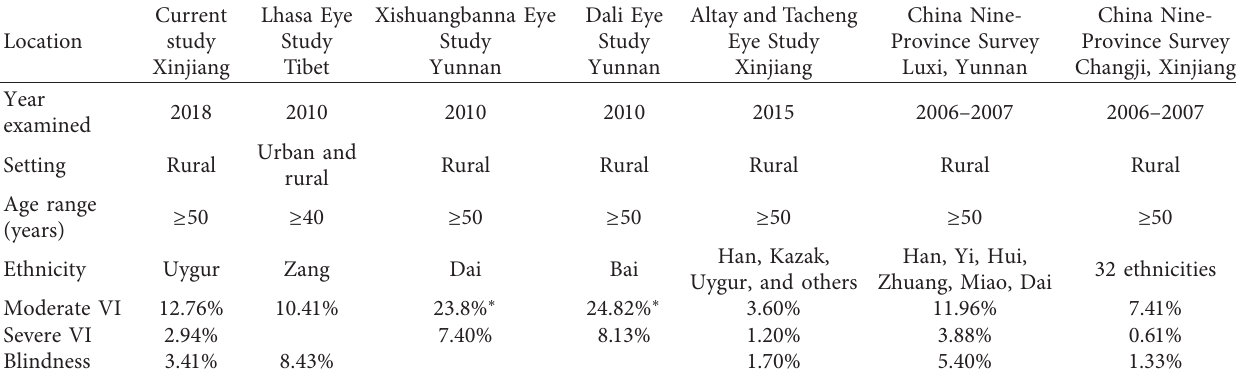
Table 3: Comparisons of the prevalence of VI or blindness with those in other minority population-based